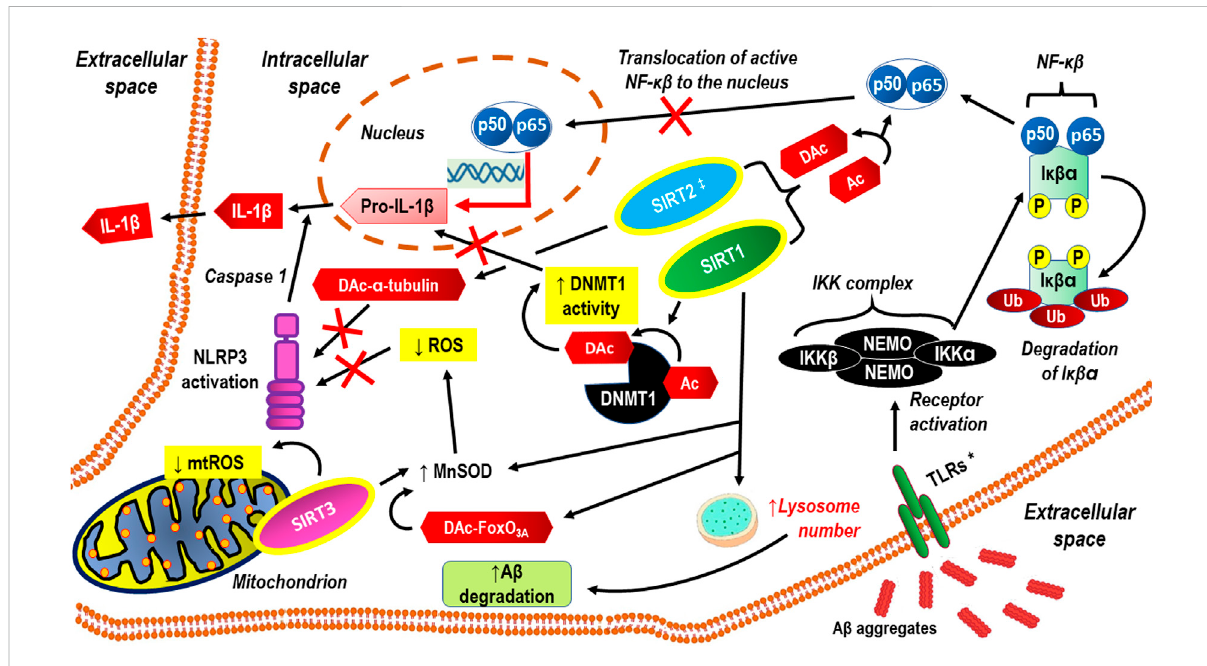
FIGURE 1 Anti-neuroin fl ammatory actions of sirtuins, through inactivation of p65 subunit of NF- κ B, activation of DNMT1 and anti-oxidative effects. A β aggregates activate cell membrane receptors that signaling though the NF- κ B signaling pathway. SIRT1 exerts neuroprotective and anti- in fl ammatory effects, inhibiting both A β production and pro-in fl ammatory activation of microglial cells through abrogating NF- κ B and IL-1 β dependent signaling pathways . Both SIRT1 and SIRT2 can inhibit neuroin fl ammation via direct deacetylation of p65. SIRT1 and mitochondrial SIRT3 counteracts oxidative stress through FoxO3A deacetylation, resulting in MnSOD activation and/or direct MnSOD activation via deacetylation. ThuslimitedformationofROSinhibitsNLRP3activation.SIRT2mayinhibitNLRP3throughdeacetylationof α -tubulin.SIRT1facilitatesA β degradation by upregulating lysosome number (Li et al., 2018). * TLRs are one example of a group of receptors that may be replaced with SRs or RAGE ‡ SIRT2 actionsseemtobemorecomplexbecauseonsomeresearchmodels,itsinhibitionabrogatesneuroin fl ammationmoreeffectivelythanitsactivation A β aggregates, aggregates of amyloid-beta; Ac, acetylation; DAc, deacetylation; DNMT1, DNA Methyltransferase 1; FoxO3A, the transcription factor Forkhead box protein O3a; IKK α , Inhibitor of nuclear factor kappa-B kinase subunit alpha; IKK β , Inhibitor of nuclear factor kappa-B kinase subunit beta; IL-1 β , interleukin 1 beta; MnSOD, manganese superoxide dismutase; mtROS, mitochondrial reactive oxygen species; NEMO, NF-kappa- β essential modulator NEMO also known as inhibitor of nuclear factor kappa-B kinase subunit gamma (IKK- γ ); NF- κβ , nuclear factor